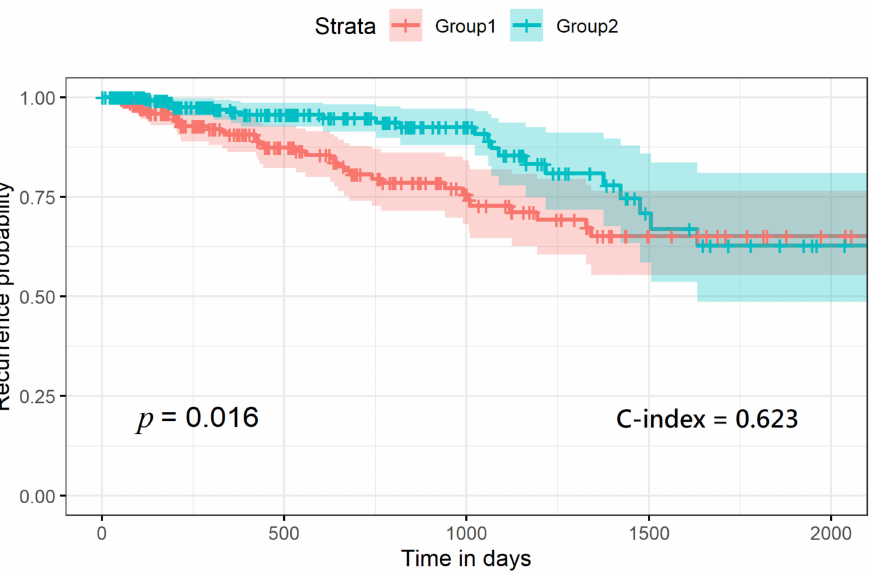
Figure 2. Recurrence-risk curves according to the labels generated from the similarity network